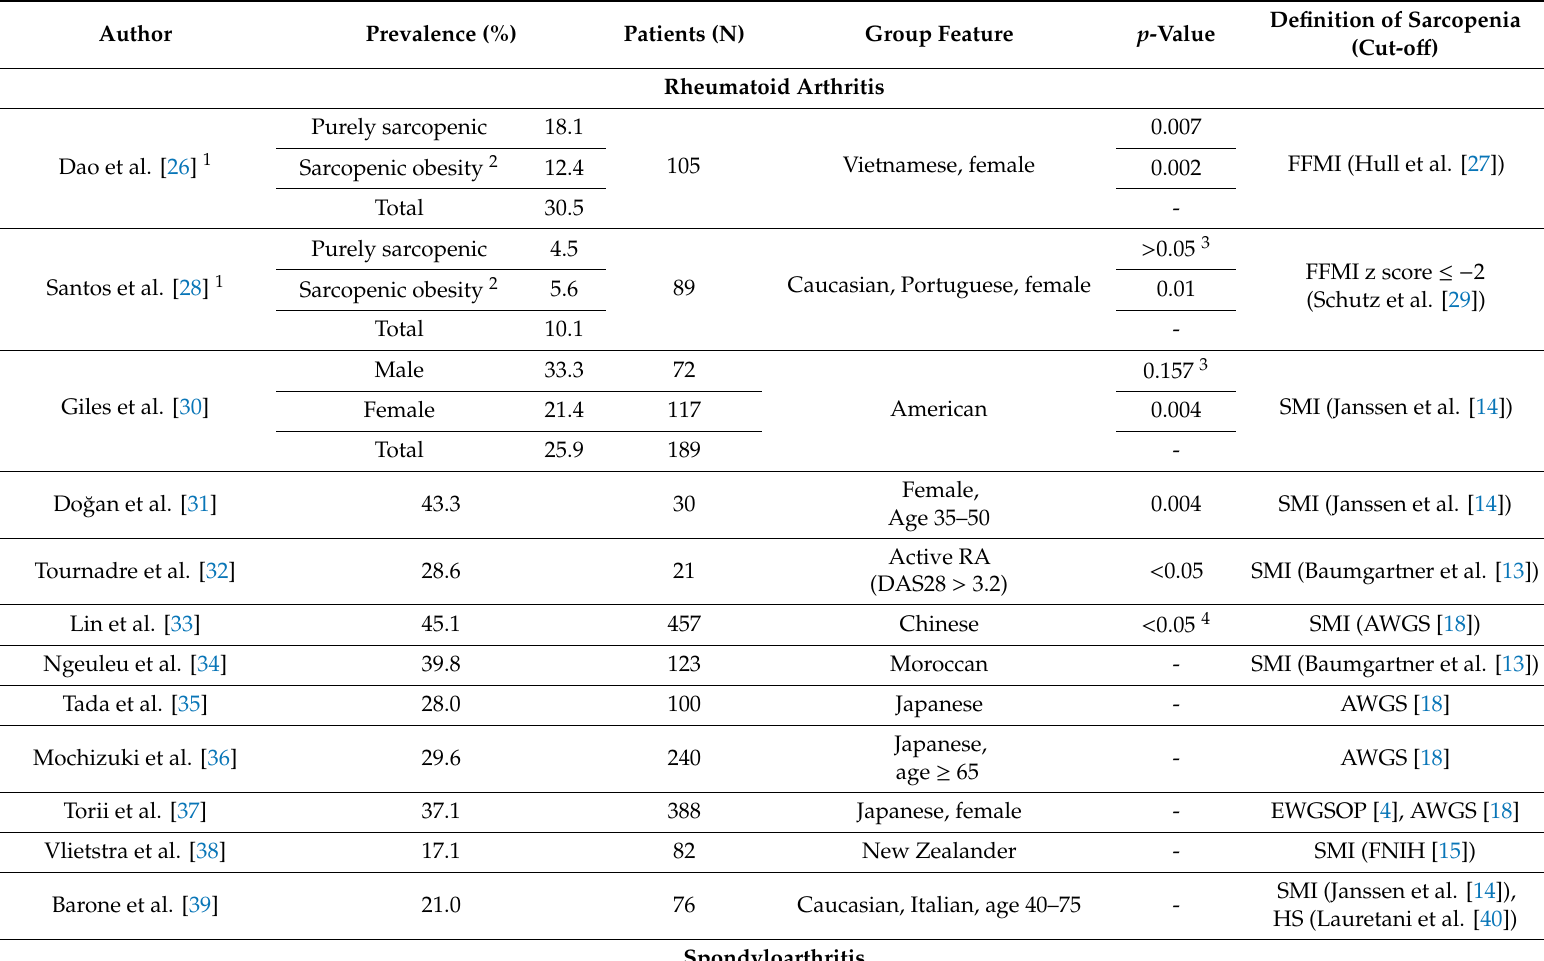
Table 1. Prevalence of Sarcopenia in Patients with Autoimmune and Rheumatic